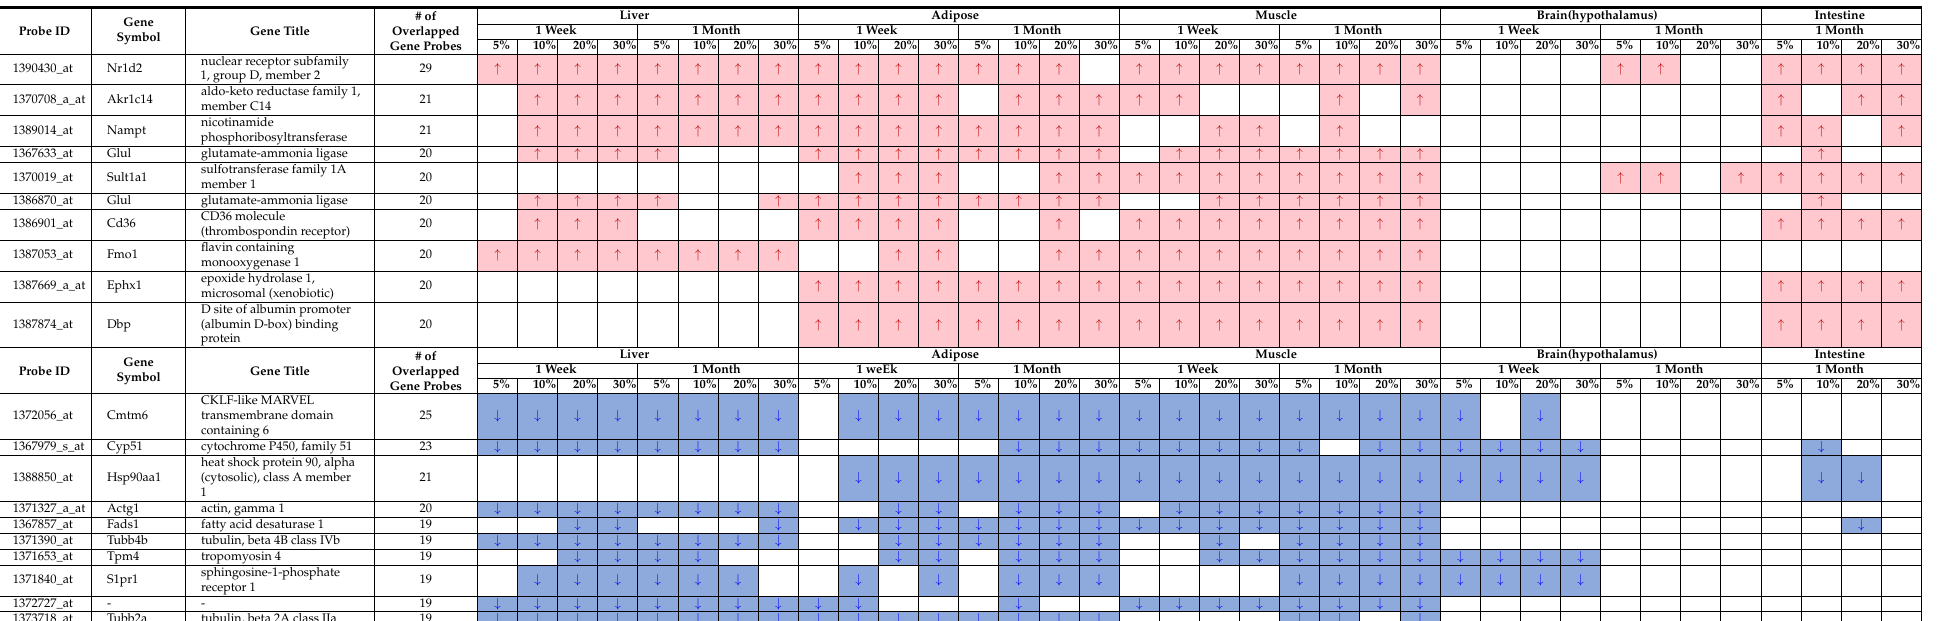
Table 4. Top-ranked genes commonly regulated by CR across all tissues